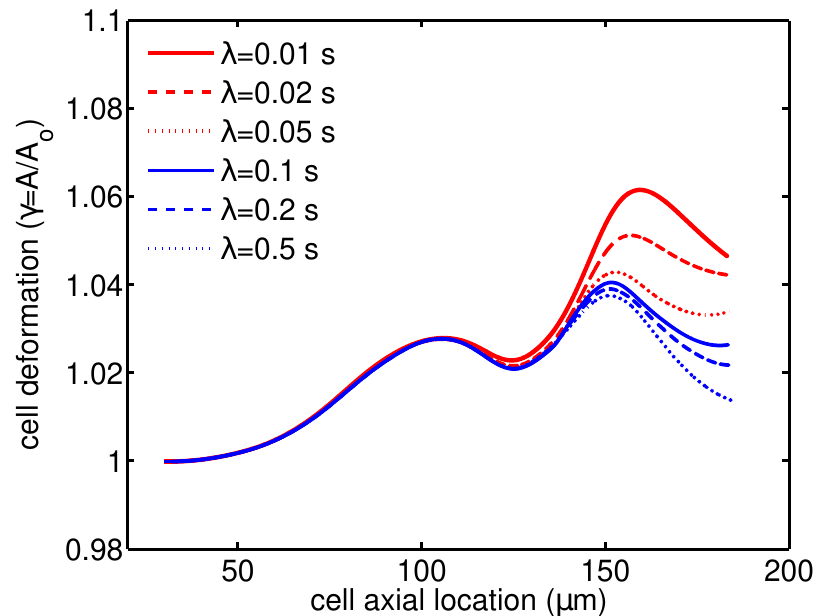
Figure 4. Deformation of an HL60 cell at different relaxation times for β = 0.5, Ca = 0.00076 and Re =